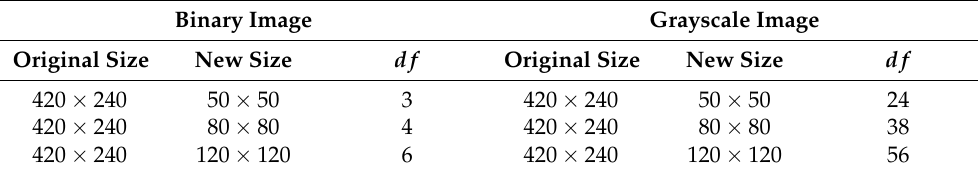
Table 4. Probable distances where the acquisition noise does not